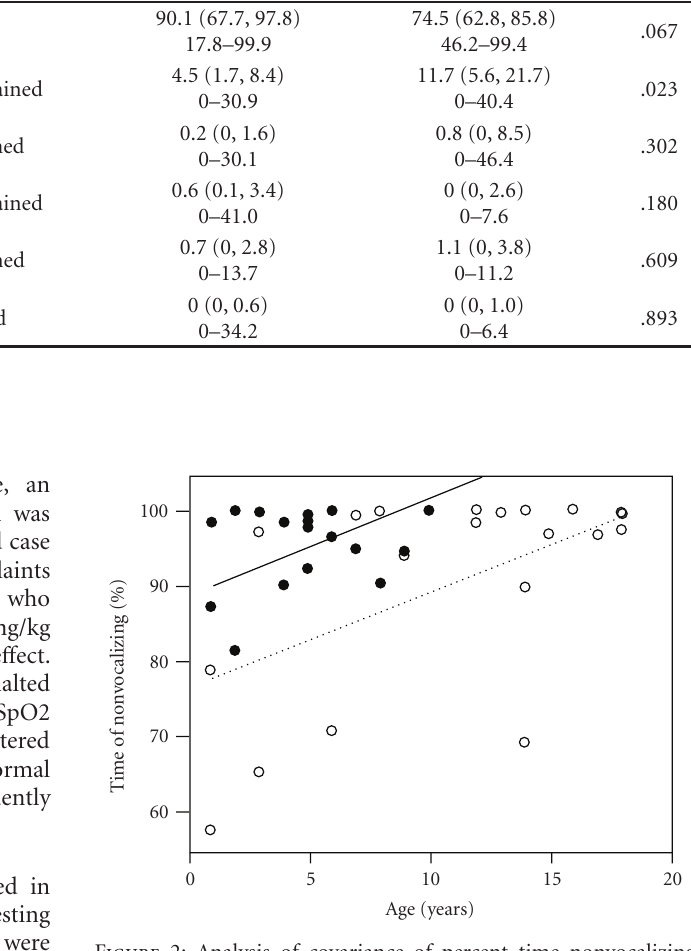
Figure 2: Analysis of covariance of percent time nonvocalizing on years of age, adjusted for sedation type. Ketamine sedation is represented by closed circles ( • ) and a solid regression line (—) while medazolam/fentanyl is represented by open circles ( ◦ ) and a dotted regression line (...). Ketamine sedation is associated with a greater percentage of time nonvocalizing compared with medazolam/fentanyl ( P = . 002), independent of the e ff ect of age. The interaction of sedation type with age was not statistically significant ( P = .